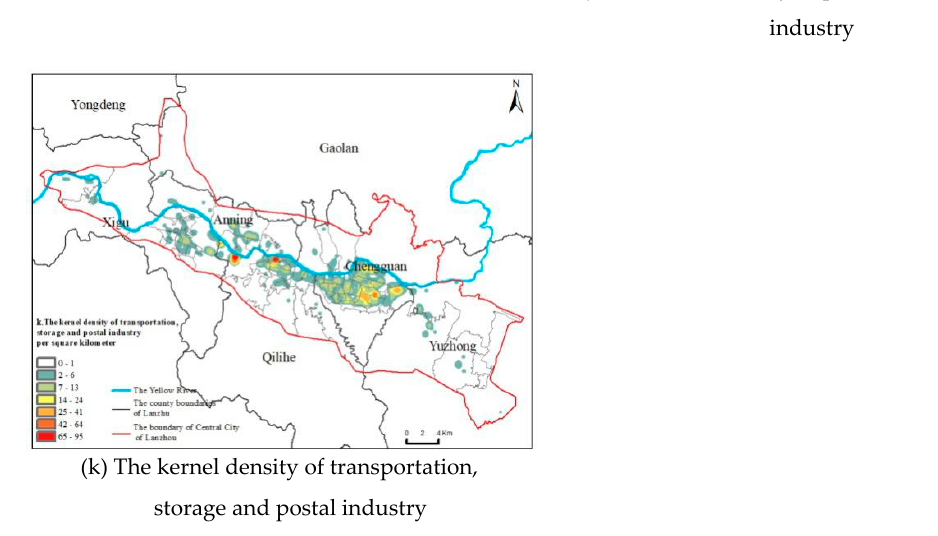
Figure 9. The kernel density distribution of different tertiary industries.